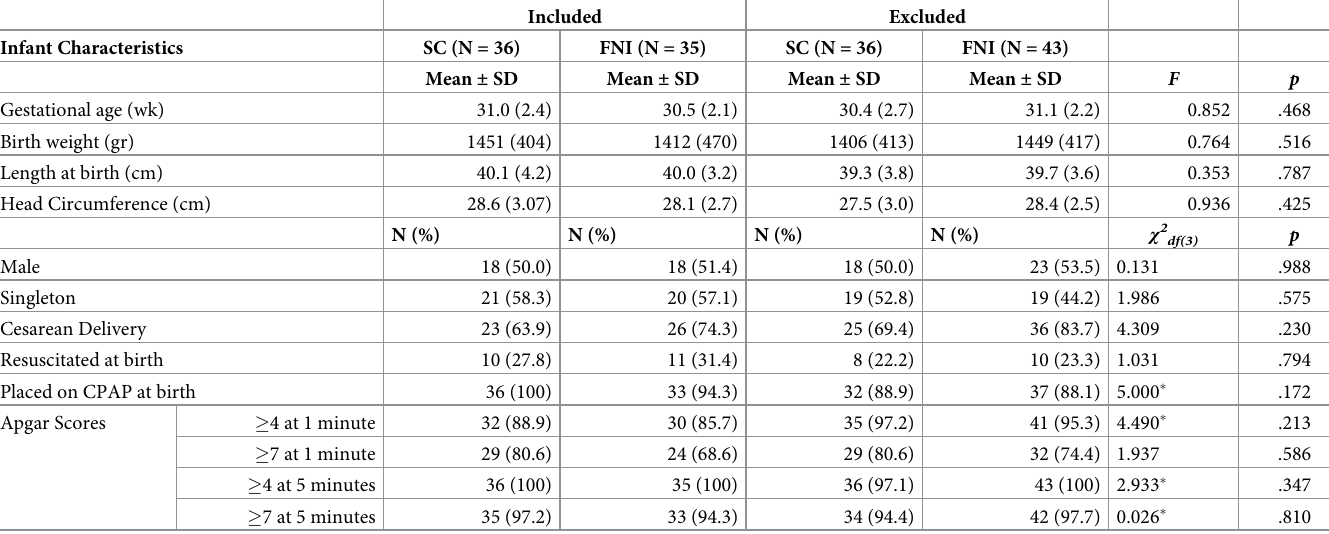
Table 2. Perinatal clinical characteristics of infants who did (Included N = 71) and did not (n = 57) return for the follow-up visit(s) at 4 to 5 years corrected age, or who returned but did not provide usable data during the lap test (n = 22) (Excluded = 79). Included Infant Characteristics